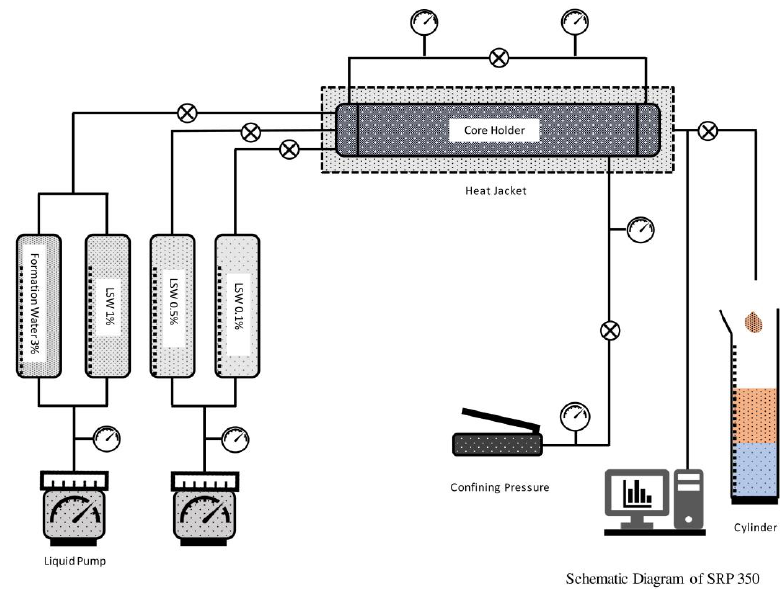
Figure 3. SRP-350 apparatus used for the core flooding